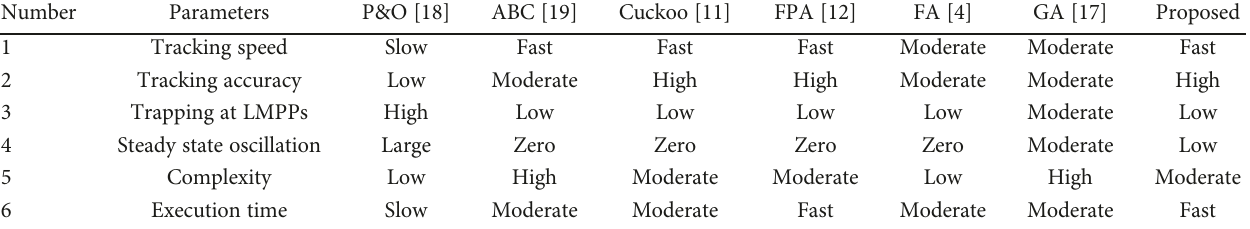
Table 14: Qualitative comparison of the proposed method with other